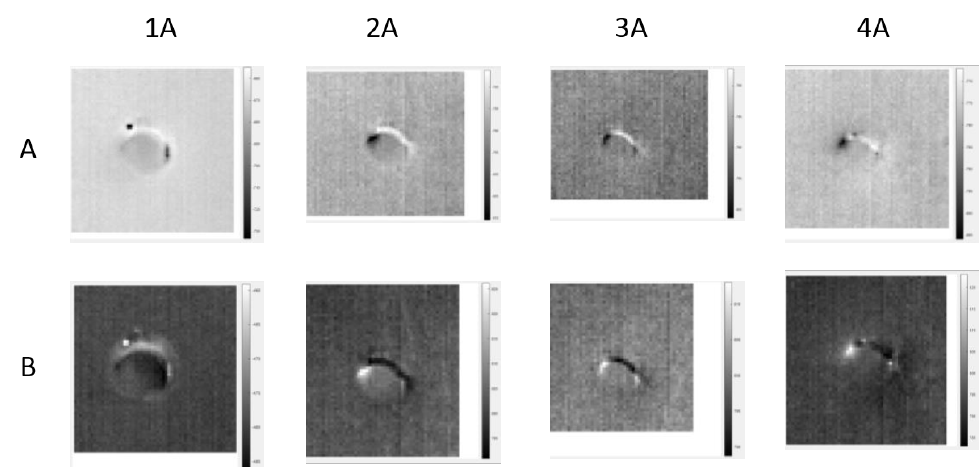
Figure 7. Results of the PCA processing of the pulse thermography data. Experiment ( A ) is conducted using an amplitude of 8 and a pulse duration of 1 s. Experiment ( B ) is conducted using the same amplitude and a pulse duration of 3 s. There are no data for sample 5A since the processing did not result in useful information. Sample shows a similar result to previous results, namely, no closed boundary can be